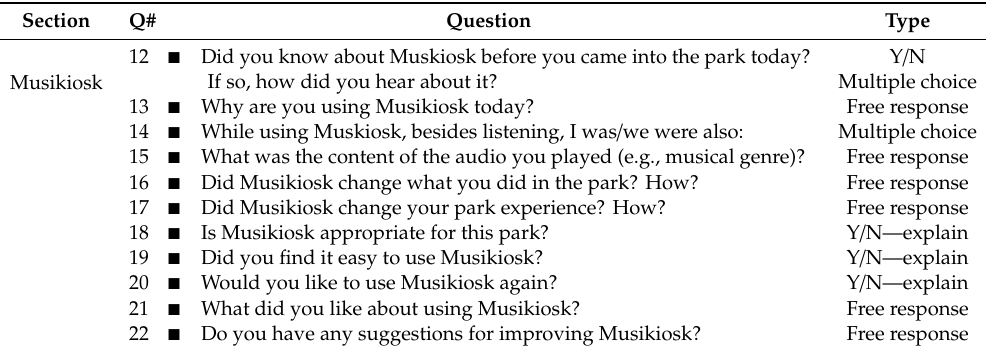
Table A2. Questionnaire Q2, Musikiosk users, presented in addition to Q1 questions.